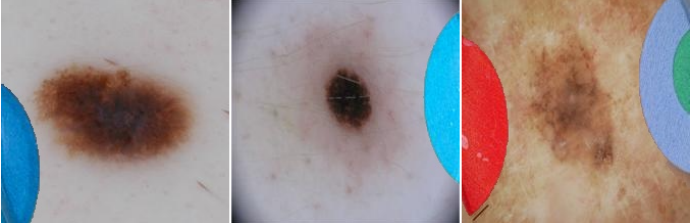
Figure 3. Three examples of images of malignant lesions with coloured patches inserted to evaluate whether the presence of a patch changes the prediction of the